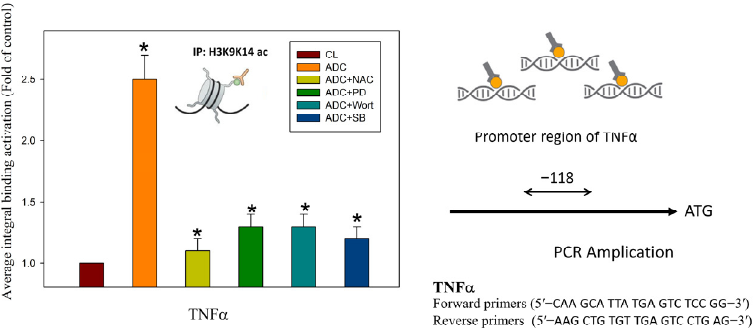
Figure 7. The kinase inhibitors block the binding activities of tumor necrosis factor (TNF) promoter regions, as induced by antrodin C treatment. The chromatin immunoprecipitation assay was per- formed using antibodies against histone H3K9K14ac (Acetyl Lys9/Lys14) and TNF α promoters (the − 118 target sites, as described in the Materials and Methods) in the precipitated DNA, which was amplified by quantitative real-time polymerase chain reaction using specific primer sets. HCT-116 cells were incubated with or without reactive oxygen species (ROS) scavengers, specific ERK1/2 MAPK inhibitor PD98059, PI3K/AKT inhibitor wortmannin, or the p38 MAPK inhibitor SB203580 for 24 h at various concentrations. The data are presented as the mean ± SD of three independent experiments. * p < 0.05, as compared to the control group.